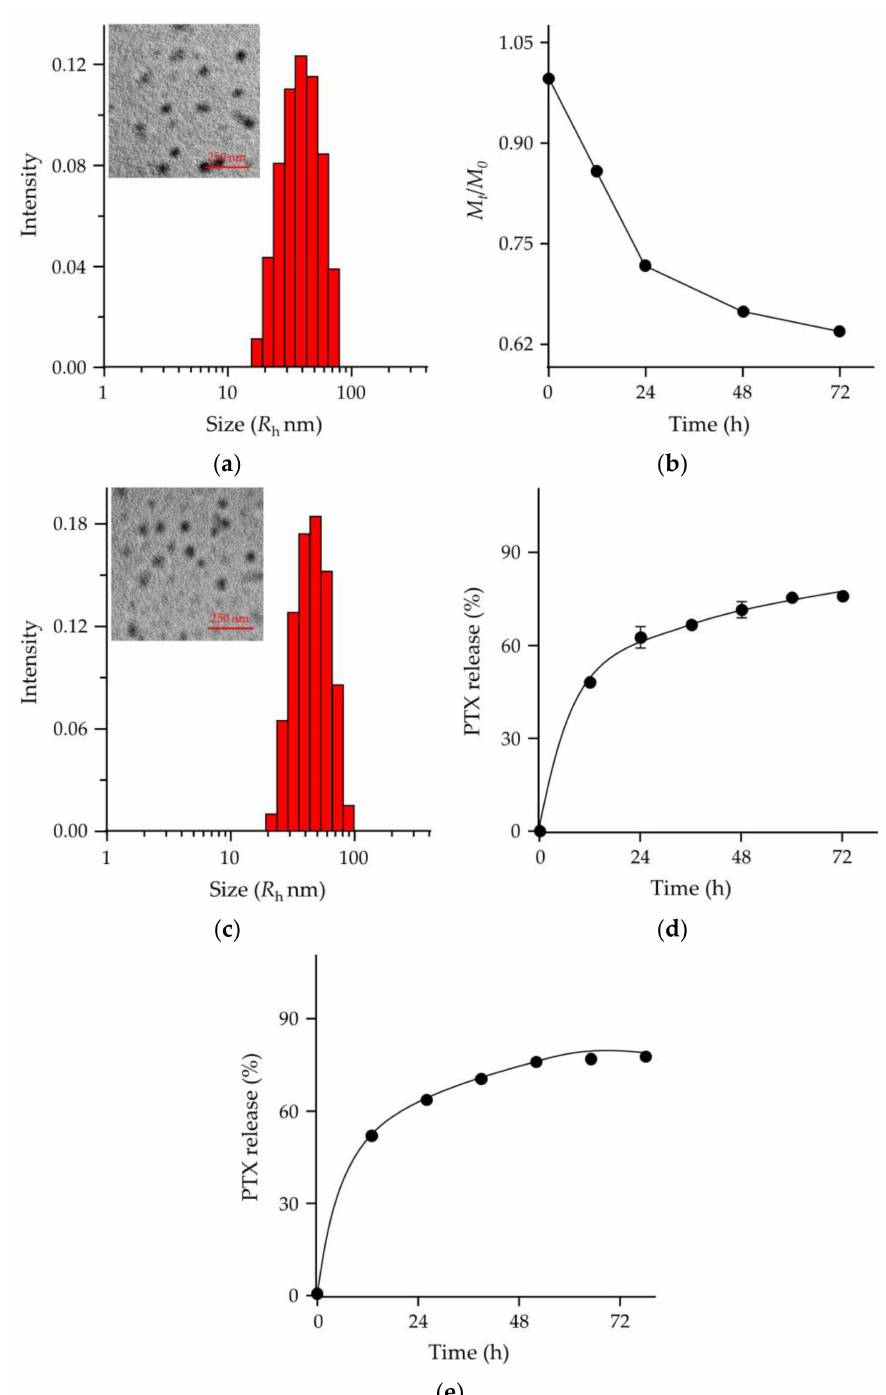
Figure 2. Characterizations of PUM and PUM / PTX. ( a ) Transmission electron microscopy (TEM) image and hydrodynamic radius ( R h ) of PUM in PBS; ( b ) M n change of PUM by GPC; ( c ) TEM image and R h of PUM / PTX in PBS; ( d , e ) PTX release behavior of PUM / PTX in phosphate-bu ff ered saline (PBS) at pH 7.4 ( d ) and pH 6.8 ( e